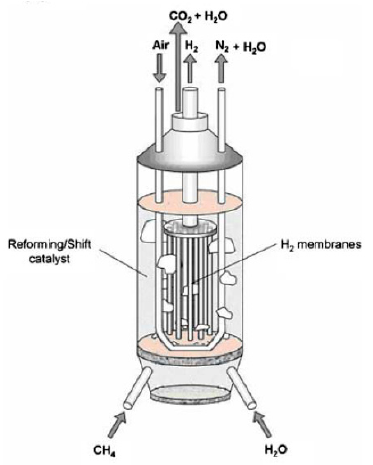
Figure 10. Membrane-assisted reforming for hydrogen production with integrated CO 2 capture. Reproduced from [32].